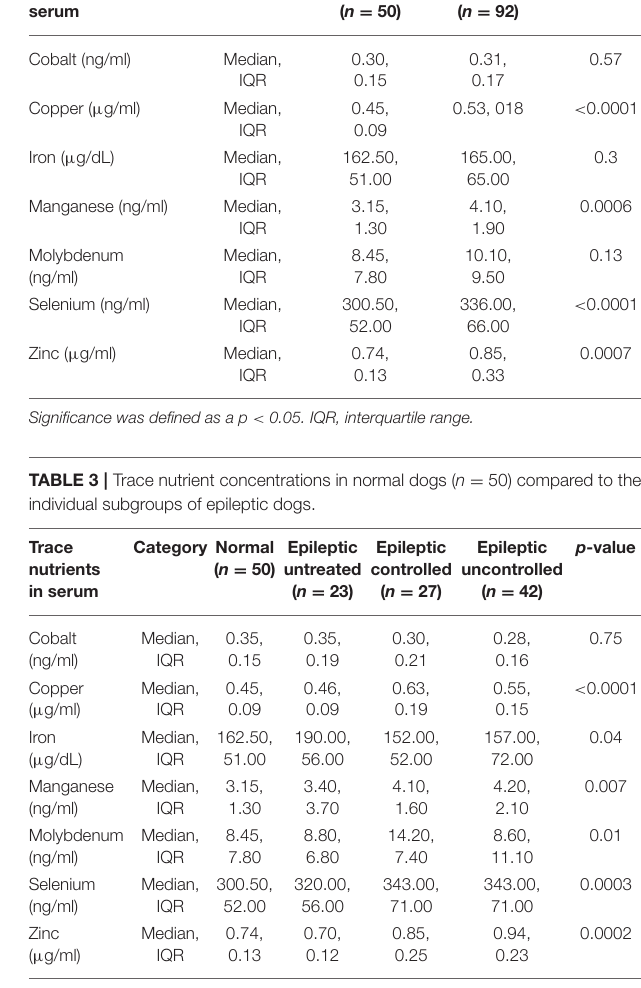
TABLE 2 | Trace nutrient concentrations in normal dogs ( n = 50) compared to all epileptic dogs as a whole ( n = 92). Trace nutrients in serum